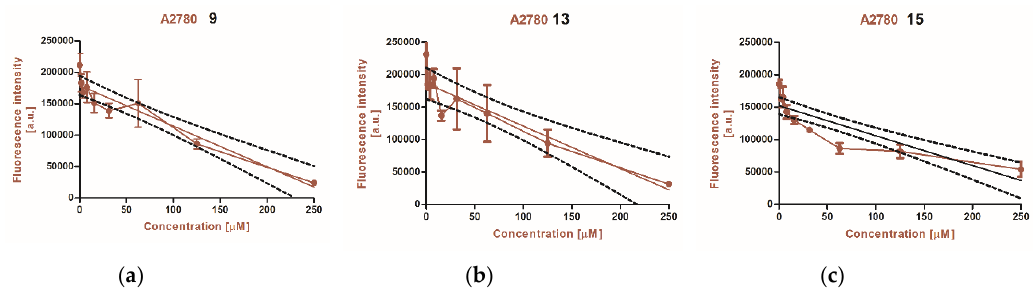
Figure 3. Linear regression of the metabolic rate of ovarian cancer cell line A2780 versus the concentrations of the fluorescent dyes: ( a ) 9, ( b ) 13 and ( c ) 15.